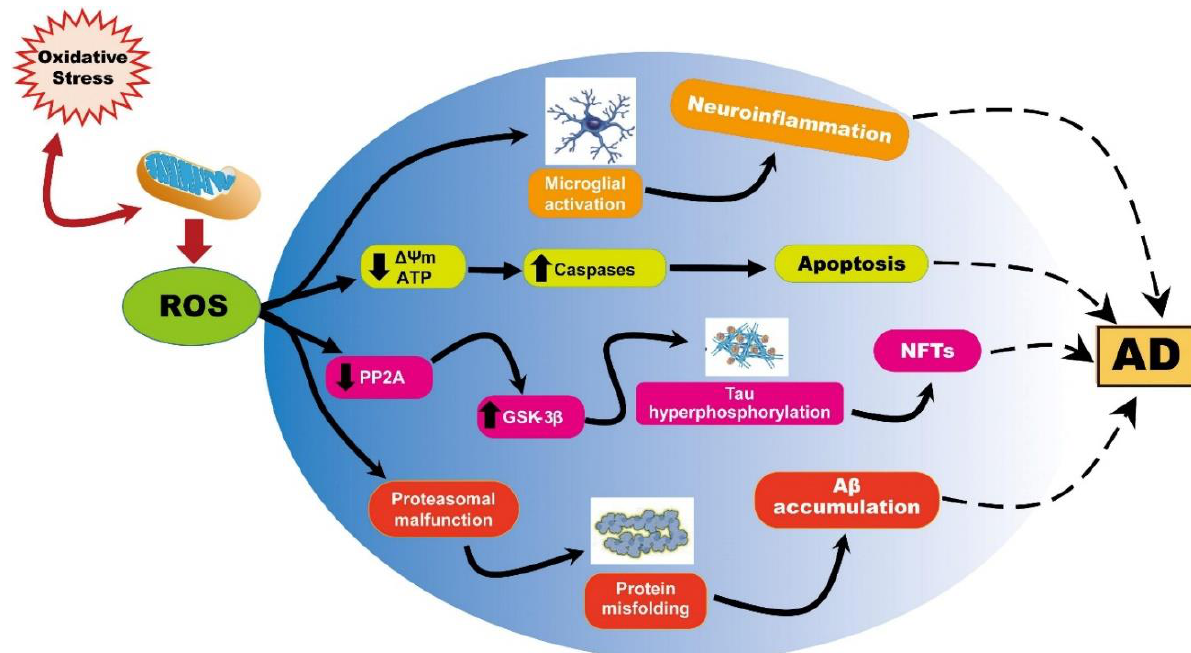
Figure 5. Representation of ROS-induced mitochondrial abnormalities in AD. Reprinted from an open-access source [9].